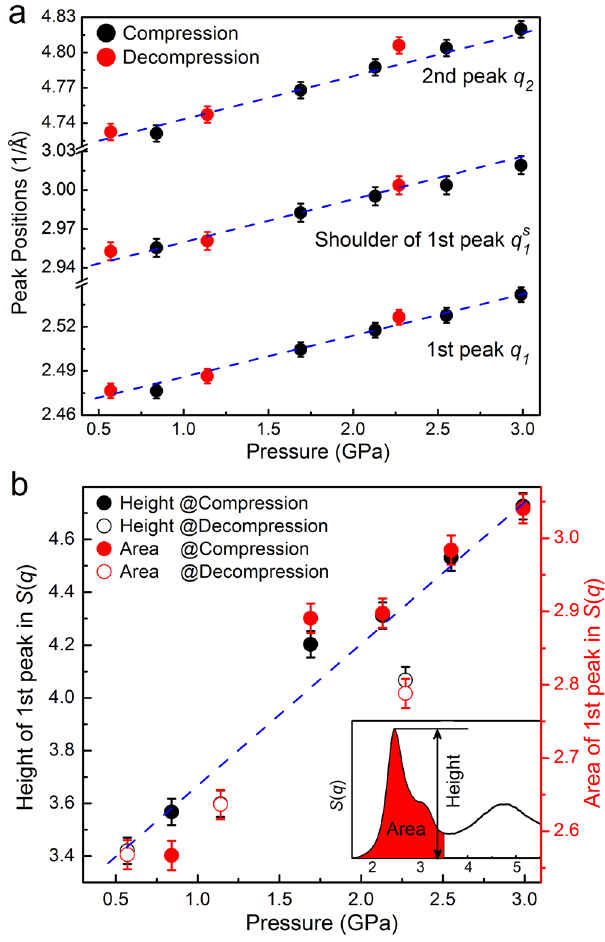
Figure 3. The 1 st and 2 nd peak positions in S ( q ) as a function of pressure prior to crystallization upon compression and after vitrification during decompression, in which the first peak is fitted by two Gaussian functions. ( b ) Pressure-induced changes of height and area (or intensity) in the first peak of S ( q ), as indicated in the